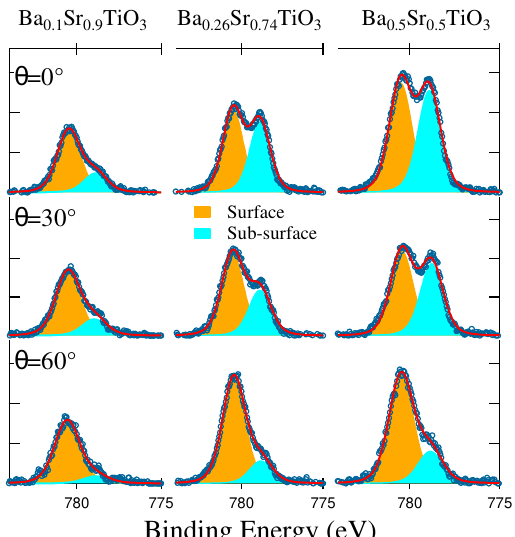
Fig. 2. Ba 3d 5/2 core-level spectra at normal emission (top), 30° (middle), and 60° (bottom) emission angles were acquired for three different BSTx surface positions corresponding to different nominal stoichiometry, i.e. BST 0.9 (left), BST 0.74 (center), and BST 0.5 (right).